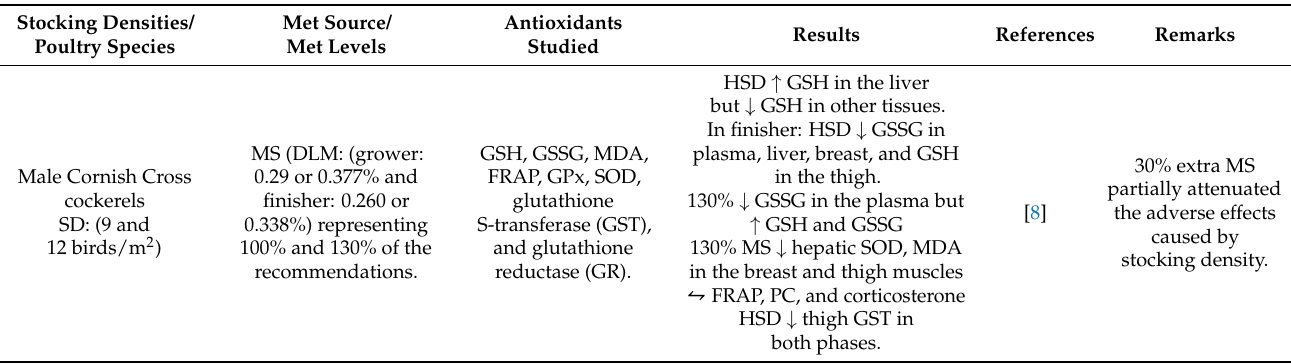
Table 2. Effect of Met on poultry oxidative stress/antioxidant status at different stocking densities and health